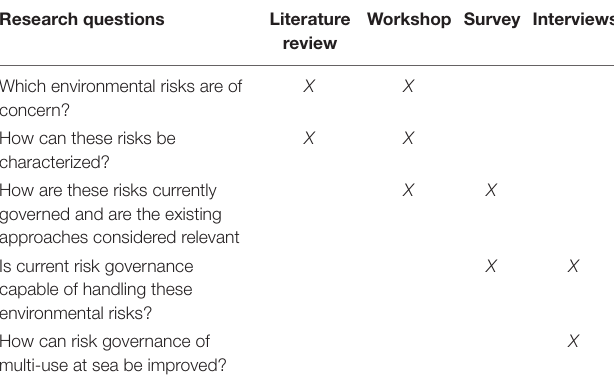
TABLE 1 | Relation between research questions and methods.